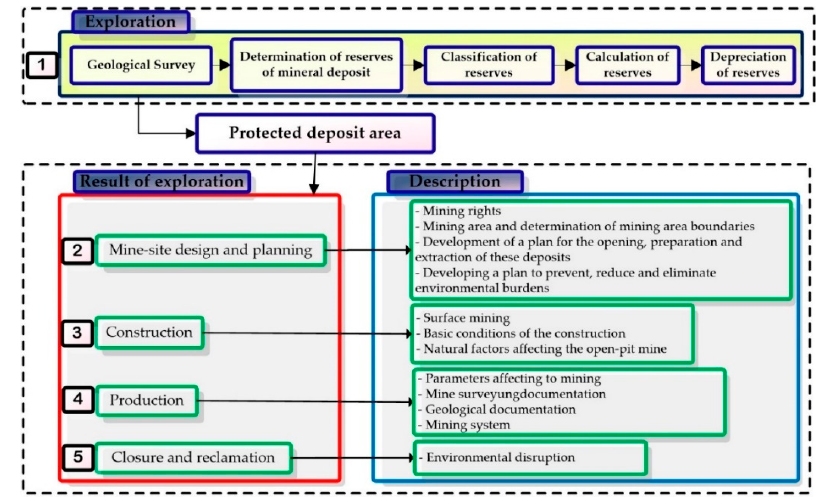
Figure 1. Life cycle of an open-pit mine (processed following the Slovak Republic mining legislation).